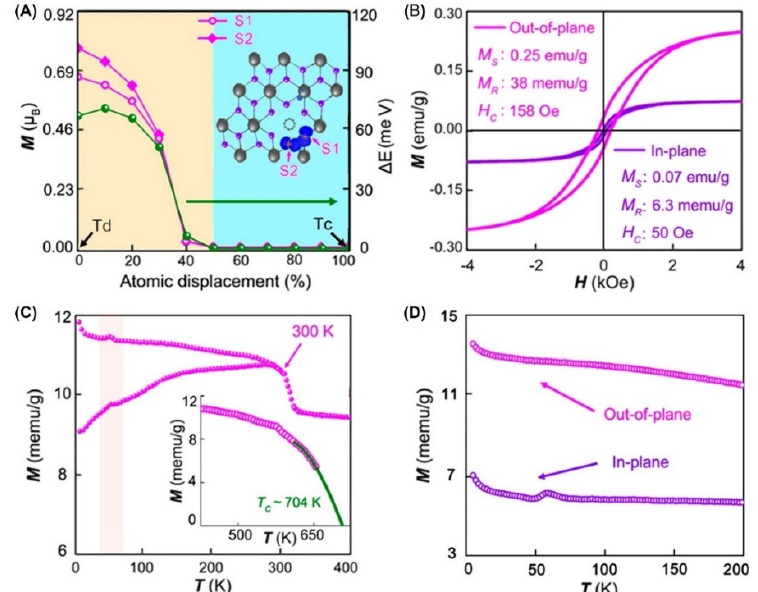
Figure 13. ( A ) Calculated magnetic moment (magenta lines) of atoms S1 and S2 and energy difference between the spin-polarized and spin-unpolarized states (olive line) versus atomic displacement from the T d to T c structures (the solid line is a guide for the eye). The inset shows the spin-resolved charge density of the two immediate neighbor atoms S1 and S2 near the Re vacancy (dashed circle). ( B ) Orientation dependence of magnetization at 300 K. ( C ) Temperature dependence of magnetic-field cooling (FC) and zero magnetic-field cooling (ZFC). The extrapolated line at higher temperatures intersects the temperature axis at 704 K, indicating the Curie temperature (inset). ( D ) Temperature dependence of the magnetic susceptibility in the out-of-plane and in-plane directions. Reprinted with permission from [17]. Copyright 2019, American Chemical Society.